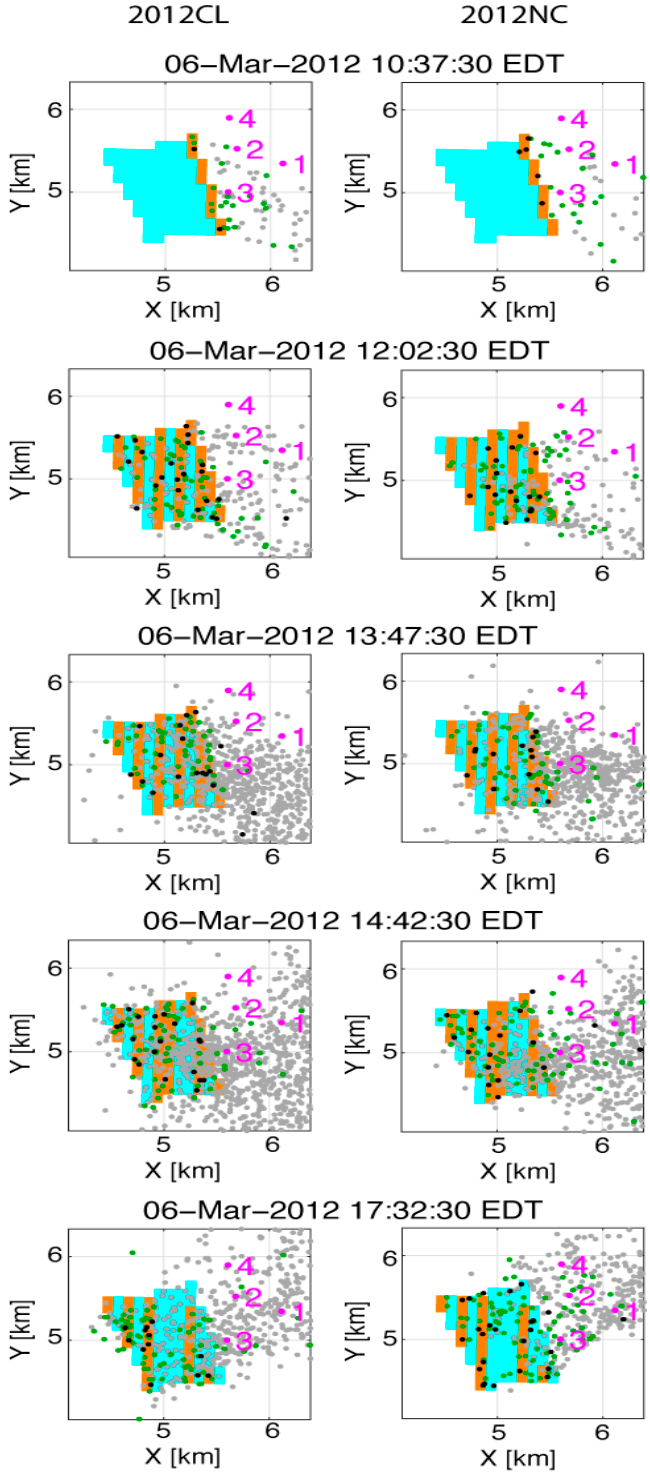
Figure 10. As in the right panels of Figure 3, but with the 2012 no-canopy simulation (2012NC) included for